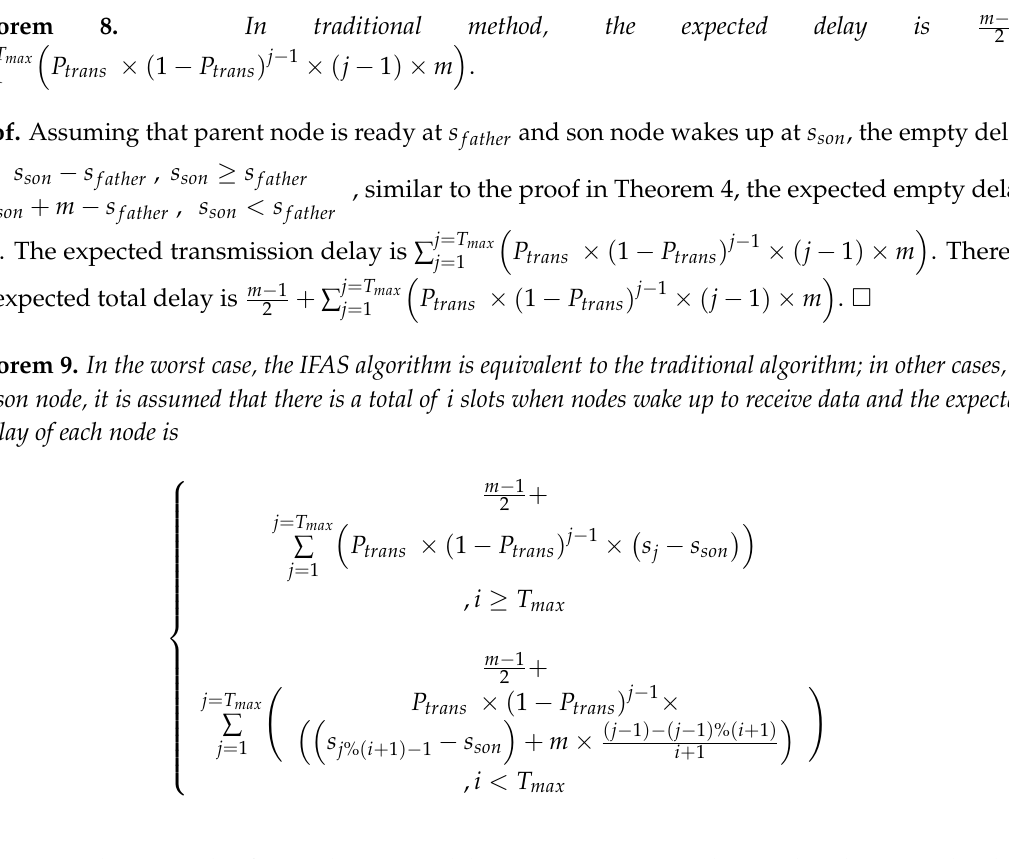
Figure 16. The influence trend of the number of nodes on slot coverage ( m = 20).